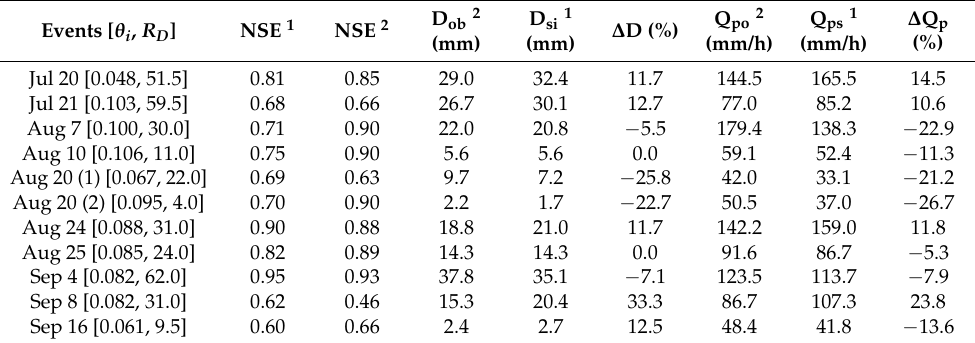
Table 1. Comparison of simulated and observed discharge parameters for 11 rainfall events.